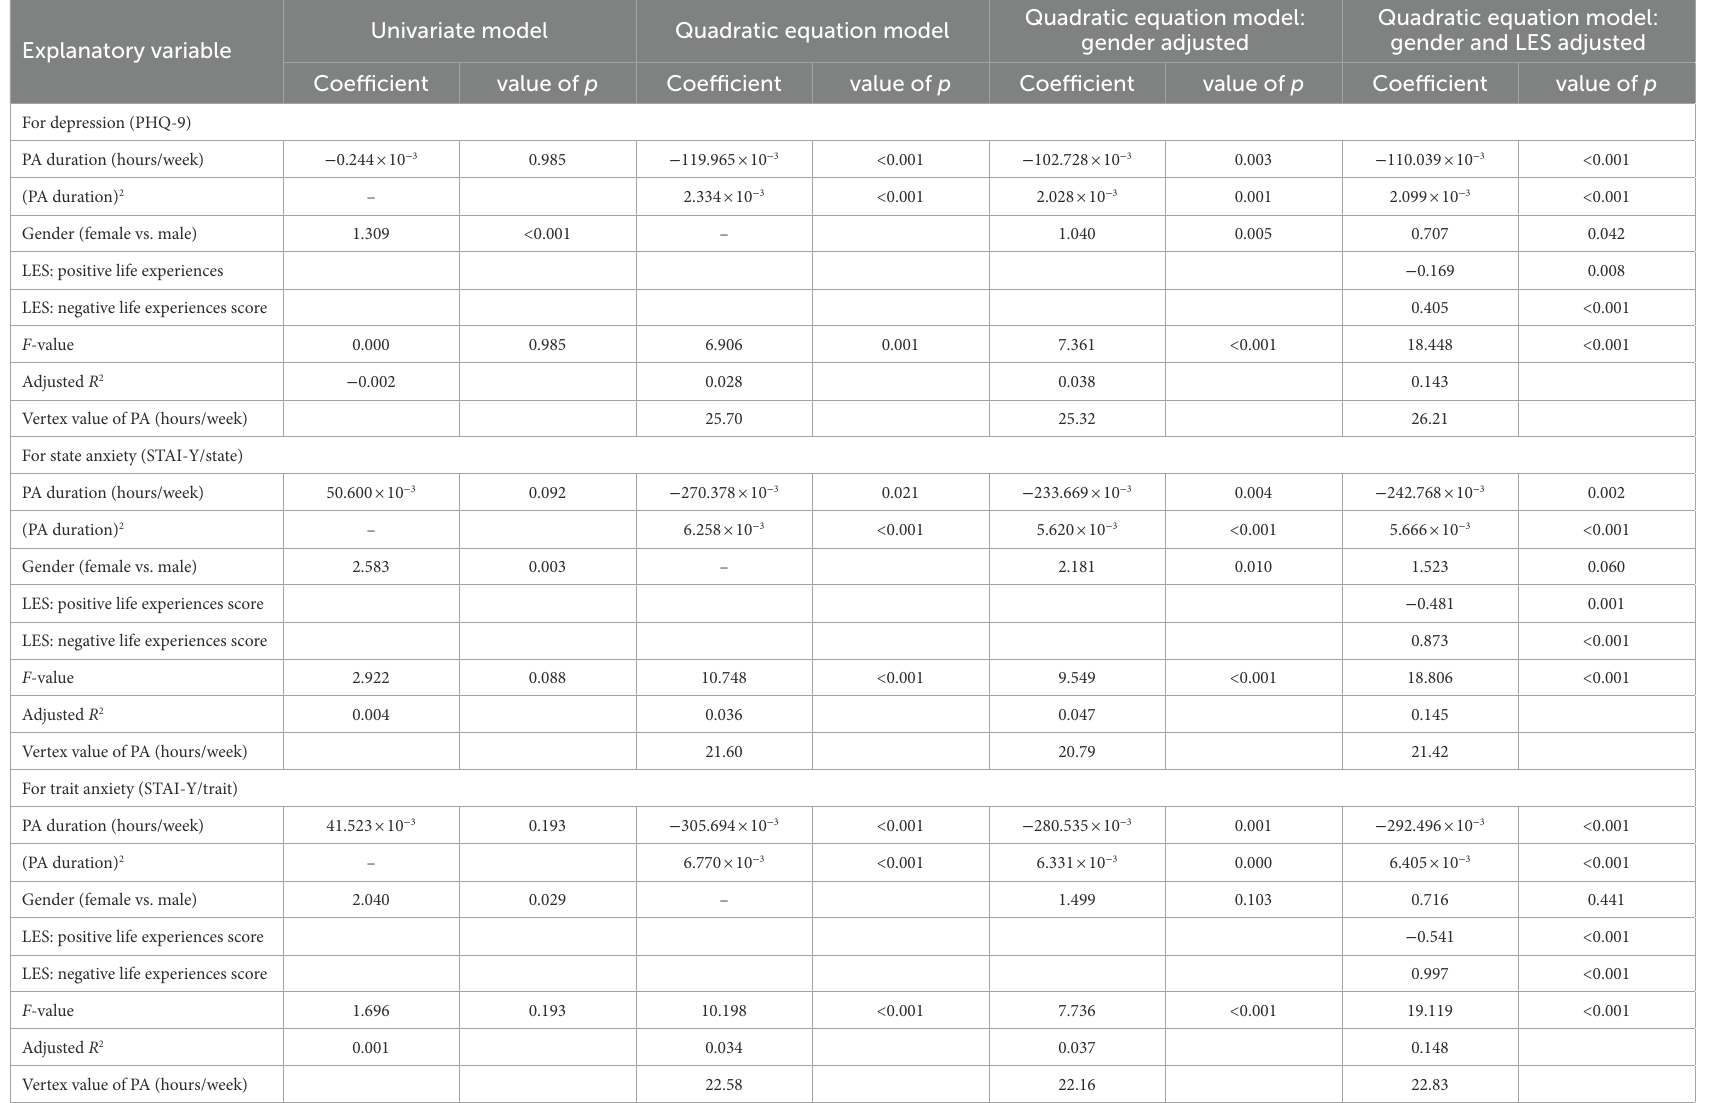
TABLE 3 Regression analyses of the effects of physical activity duration on mental health